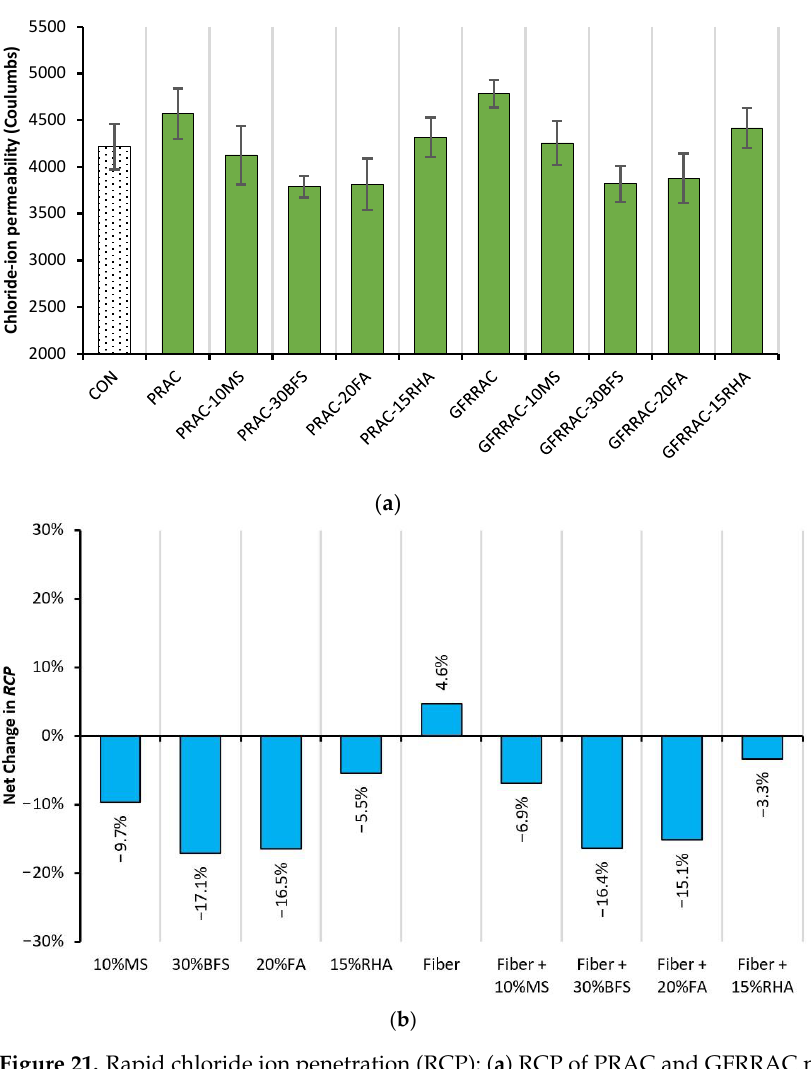
Figure 21. Rapid chloride ion penetration (RCP): ( a ) RCP of PRAC and GFRRAC mixtures with different mineral admixture; ( b ) net change in RCP due to the addition of fibers and mineral admixtures.